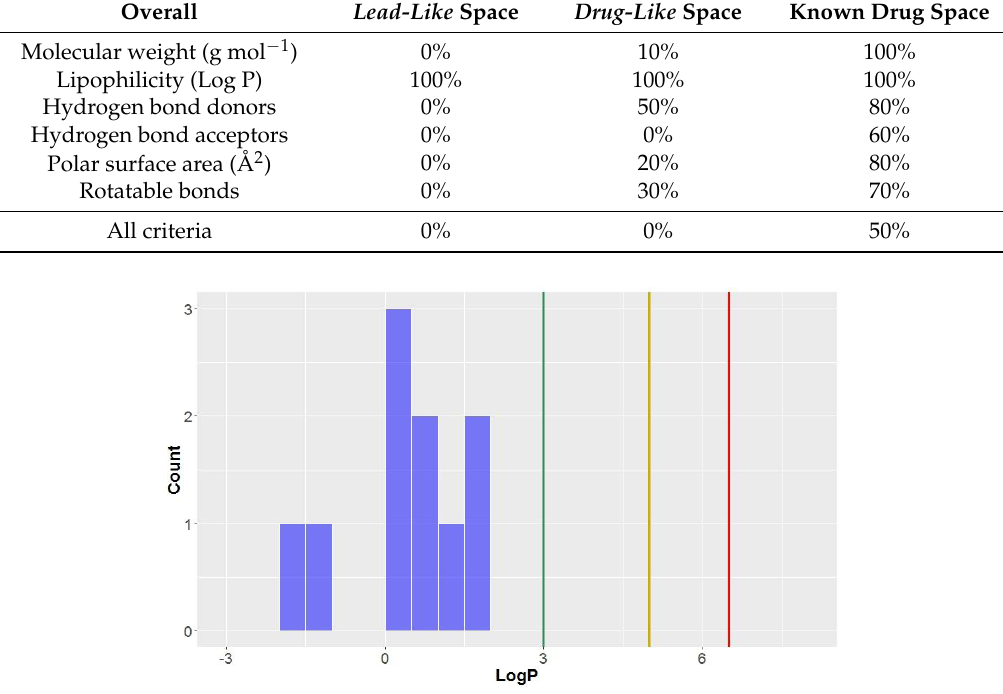
Figure 14. The statistical distribution of the octanol–water partition coefficient (LogP) of the CLCs (green = 3, compounds < 3 are in the lead-like space; yellow = 5, compounds < 5 are in the drug-like space; red = 6.5, compounds < 6.5 are in the KDS). Total number of compounds = 10.